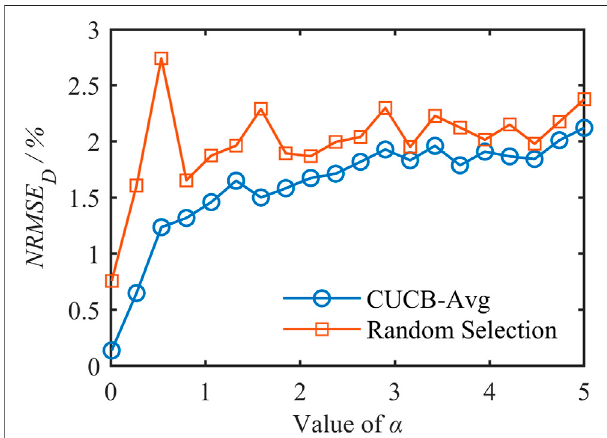
FIGURE 8 | NRMSE D of D = 1.6